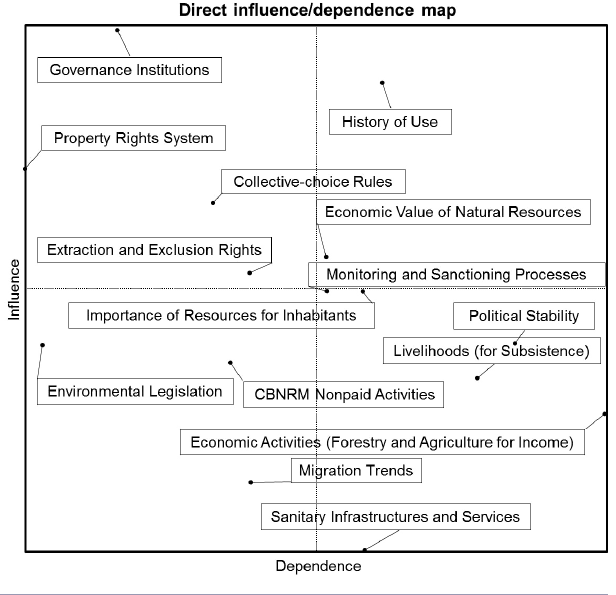
Fig. 6 . Influence/dependence map for direct influences in Mexico.